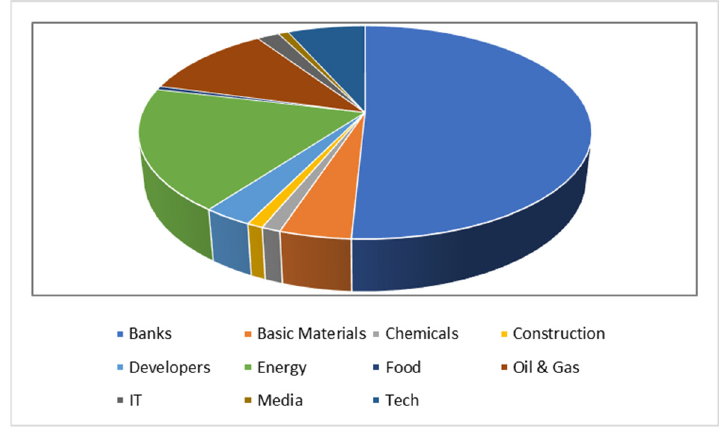
Figure 2. The structure of the market capitalization of the Polish stock market according to different sectors. Source: Data processed by the authors are from www.investing.com (accessed on 14 June 2022).